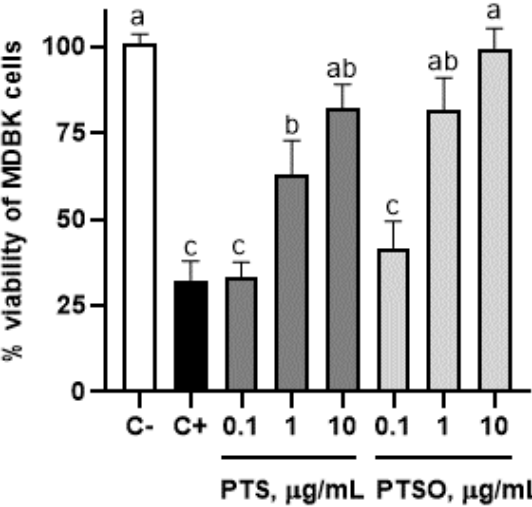
Figure 3. Viability percentage of MDBK cells infected with E. acervulina sporozoites that were previously incubated at different concentrations of PTS or PTSO. Different letters between columns indicate significant differences at p < 0.05.